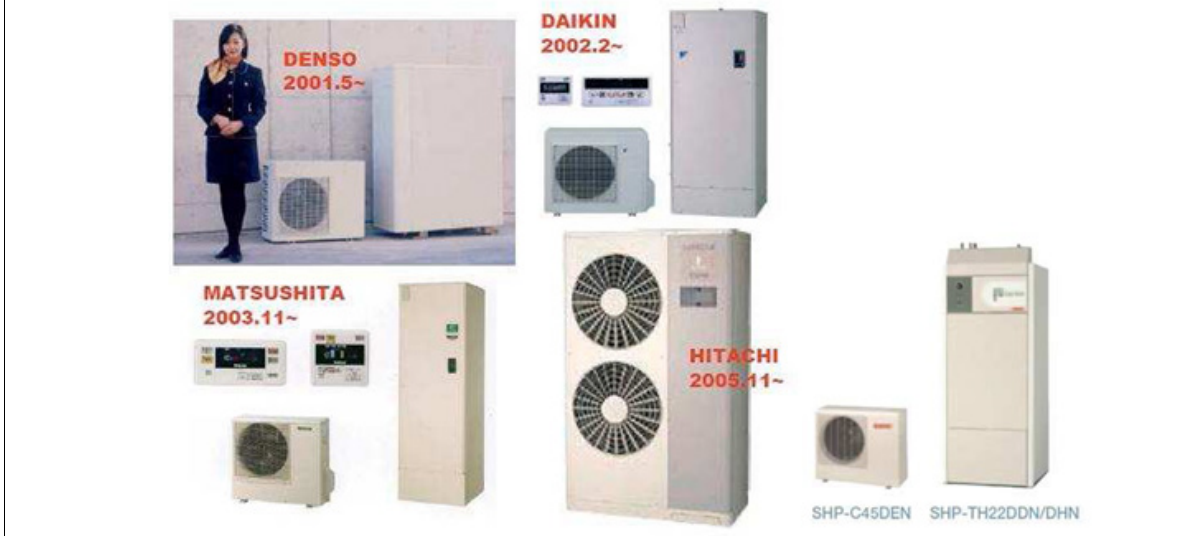
Figure 4: Examples of EcoCute heat pumps.